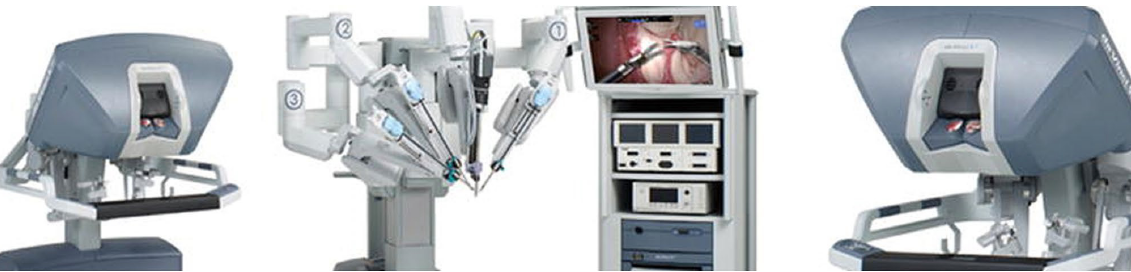
Figure 5. The da Vinci surgical system (Intuitive Surgical, Inc., Sunnyvale, CA, United States) [102,104].